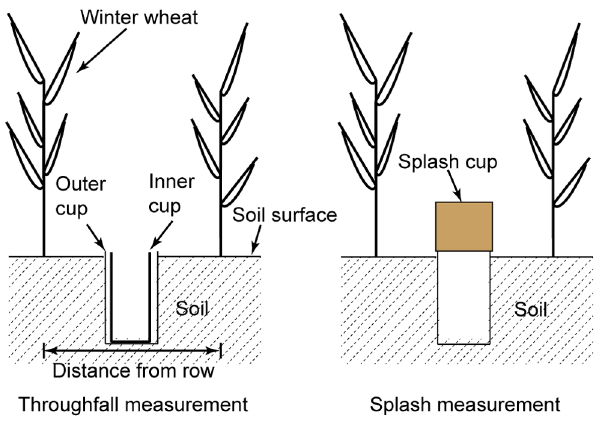
Figure 2. Measurement for throughfall and splash detachment under wheat